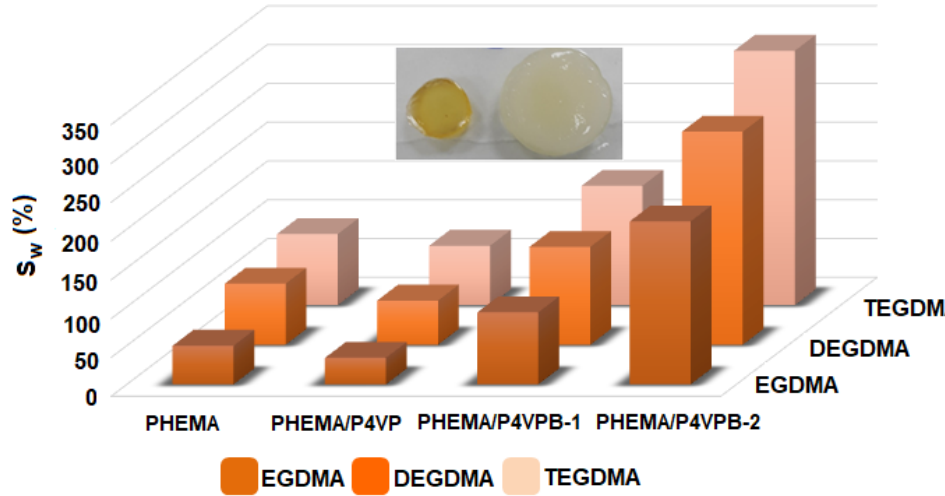
Figure 3. Influence of the chemical structure of the cross-linking agent on the maximum swelling degree in water.